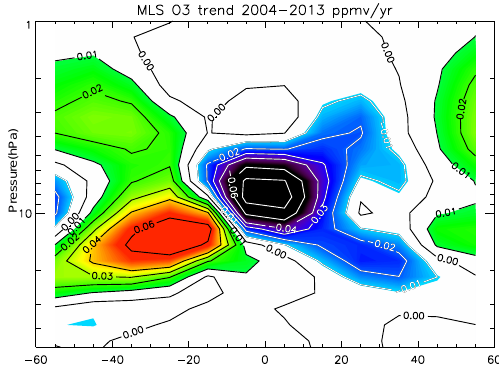
Figure 2. The calculated linear trend in HALOE ozone for 1991– 2005. The HALOE data has been sorted into 11 individual 10 ◦ lati- tude bins from 55 ◦ S to 55 ◦ N. Regions where the magnitude of the trend is <0.01ppmvyear − 1 are indicated in white.